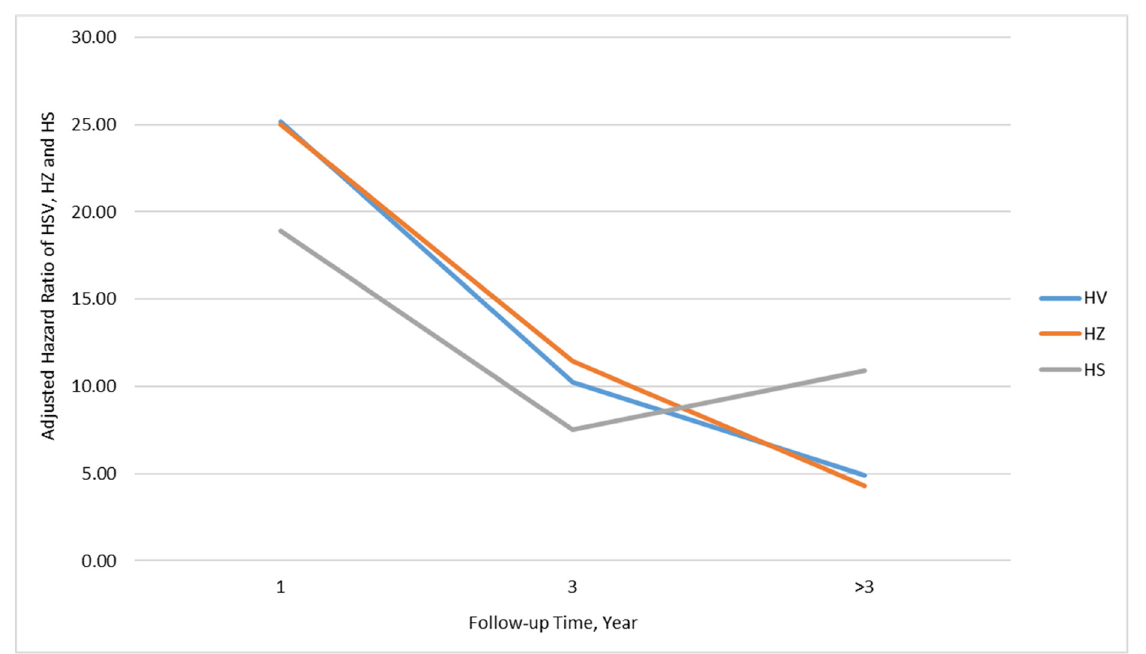
Table 5. Recurrent risk of aHV infection in groups through competing-risks regression.